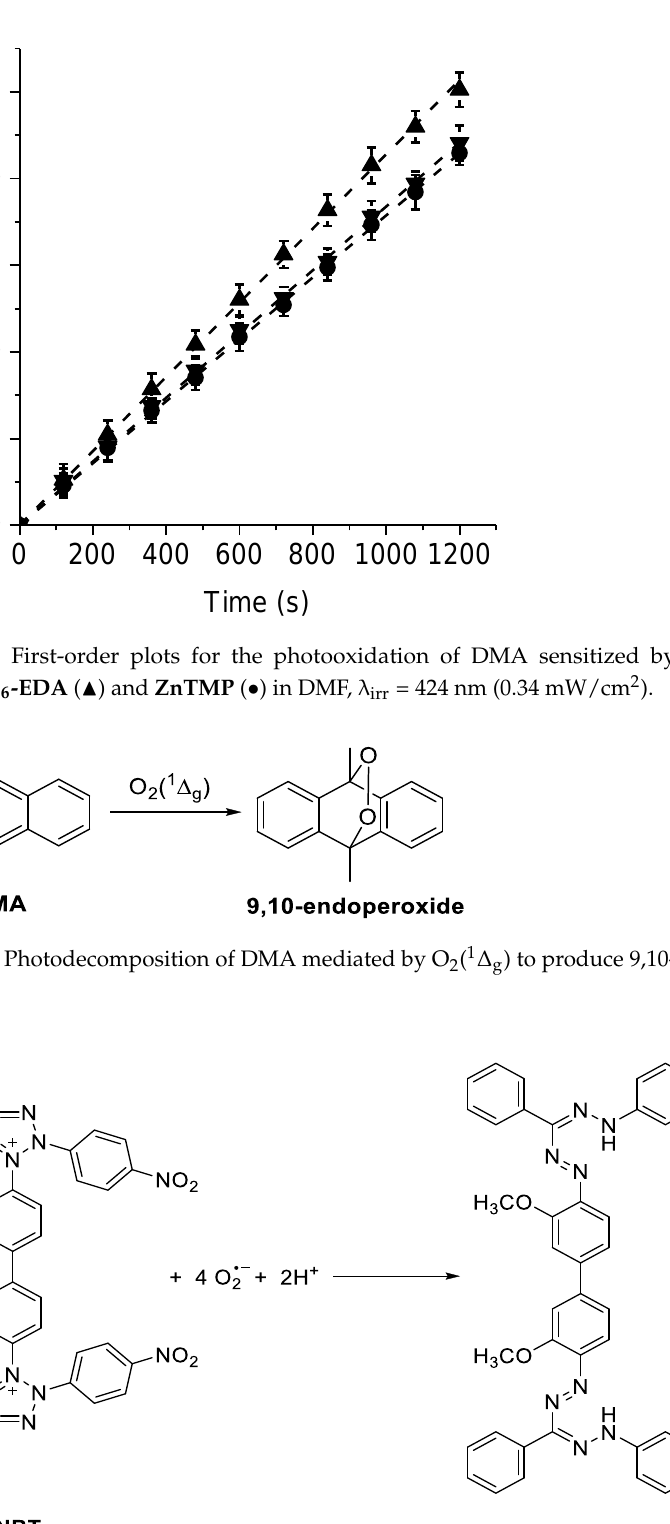
Scheme 3. Photodecomposition of DMA mediated by O 2 ( 1  g ) to produce 9,10-endoperoxide.